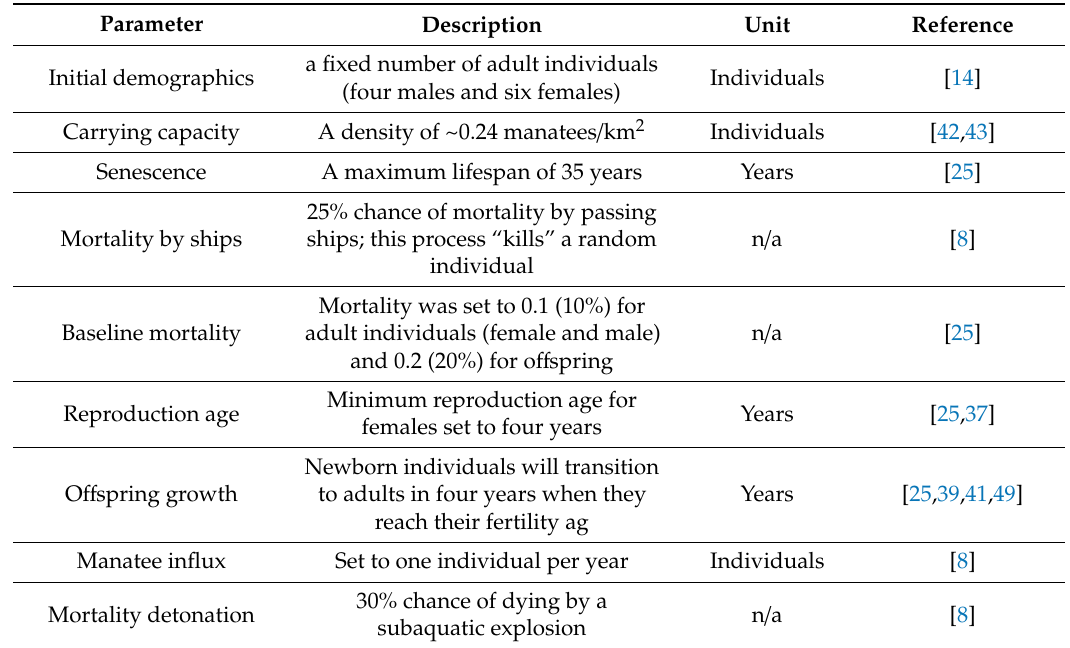
Table A1. Parameters of the model, including a description, unit, and parametrization